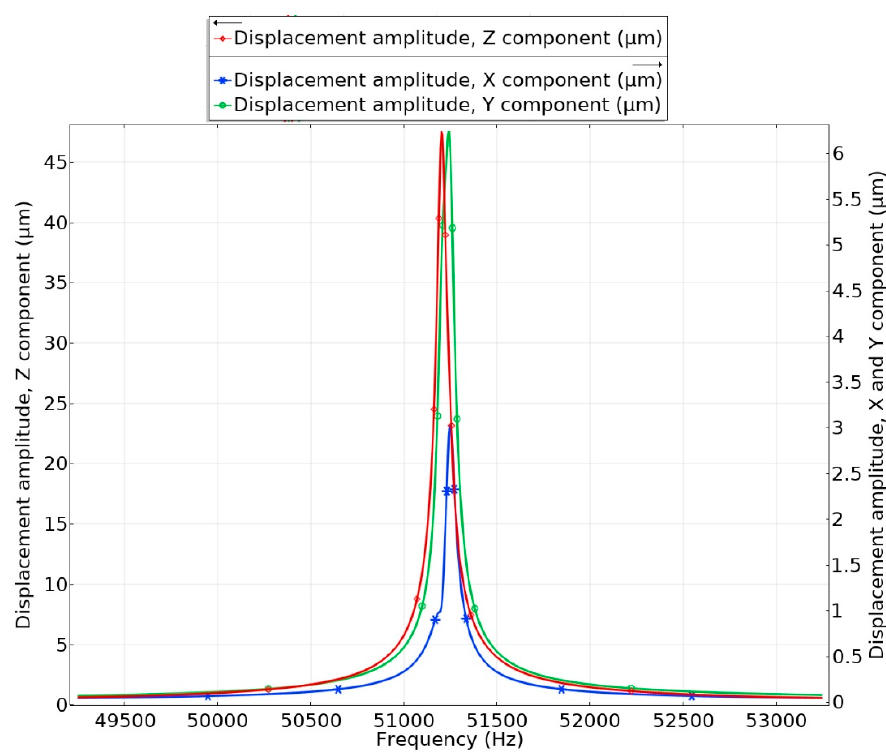
Figure 5. Amplitude–frequency characteristics of the contact point.